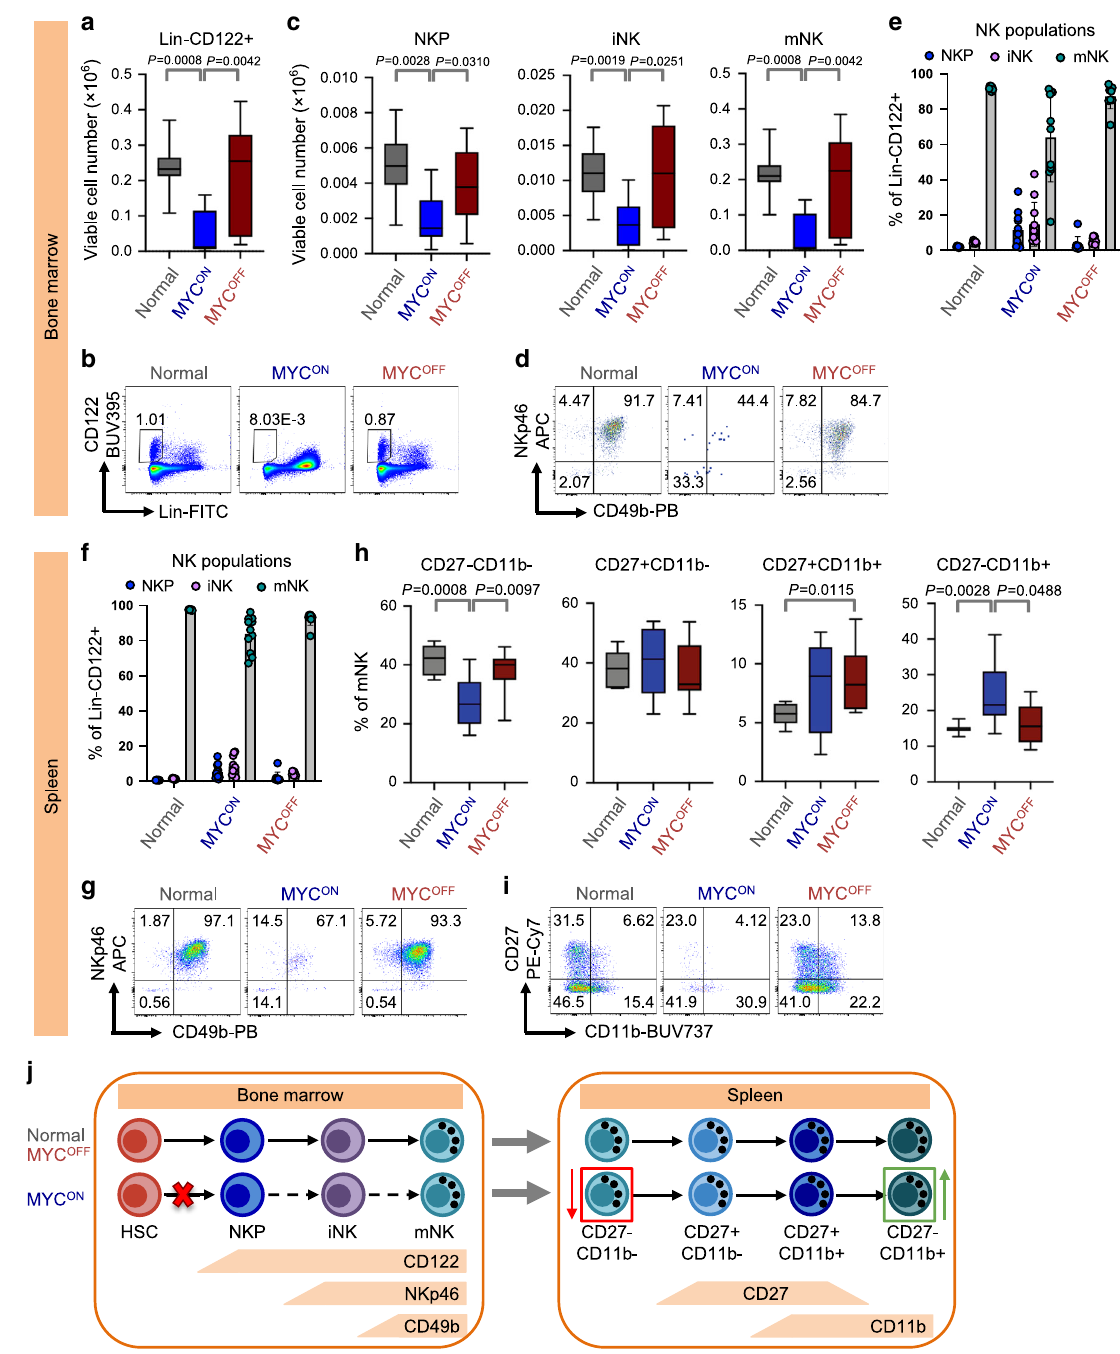
Fig. 3 Maturation of NK cells is arrested in mice bearing overt MYC-driven T-lymphomas. a , b Quanti fi cation of viable cell numbers ( a ) representative fl ow cytometry plots ( b ) of Lin − CD122 + in bone marrow from normal ( n = 7), SR α -tTA MYC ON ( n = 11) and SR α -tTA MYC OFF (doxycycline 96h, n = 9) measured by fl ow cytometry. c – e Quanti fi cation of viable cell numbers ( c ), representative fl ow cytometry plots ( d ) and percentages ( e ) of NK precursors (NKP, Lin − CD122 + NKp46 − CD49b − ), immature NK cells (iNK, Lin − CD122 + NKp46 + CD49b − ) and mature NK cells (mNK, Lin − CD122 + NKp46 + CD49b + ) in bone marrow from normal ( n = 7), SR α -tTA MYC ON ( n = 11) and SR α -tTA MYC OFF (doxycycline 96h, n = 9). Data in e show mean + s.d. f , g Quanti fi cation of percentages ( f ) and representative fl ow cytometry plots ( g ) of NKP, iNK and mNK in spleen from normal ( n = 7), SR α -tTA MYC ON ( n = 11) and SR α -tTA MYC OFF (doxycycline 96h, n = 9). Data in f show mean + s.d. h , i Quanti fi cation of percentages ( h ) and representative fl ow plots ( i ) of mNK cells expressing CD27 and CD11b in spleen from normal ( n = 7), SR α -tTA MYC ON ( n = 11) and SR α -tTA MYC OFF (doxycycline 96h, n = 9). Populations are gated on Lin − CD122 + NKp46 + CD49b + intact live singlets. j Model depicting the arrest in differentiation from HSC to NKP stage in bone marrow and the changes in mature splenic NK effector subsets during MYC-driven lymphomagenesis. Arrested step in NK cell differentiation is indicated by a red cross and dashed arrows indicate stages of NK cell differentiation that do not occur because of the arrest. The red and green boxes indicate NK effector subsets whose frequencies are reduced and enhanced respectively, during MYC-driven lymphomagenesis. p -values have been calculated using a two-sided Mann – Whitney test. For all box plots, the center is at the median, minima and maxima are indicated by whiskers, and the box represents data between the 25th and 75th